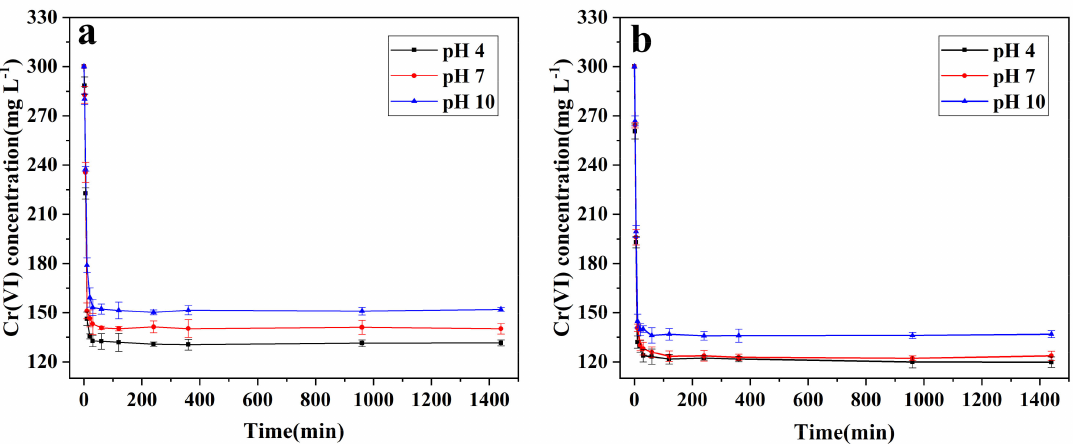
Figure 2. Effect of initial pH on Cr(VI) removal by nZVI ( a ) and B-nZVI ( b ). Error bars indicate the standard deviation of the mean (n = 3).